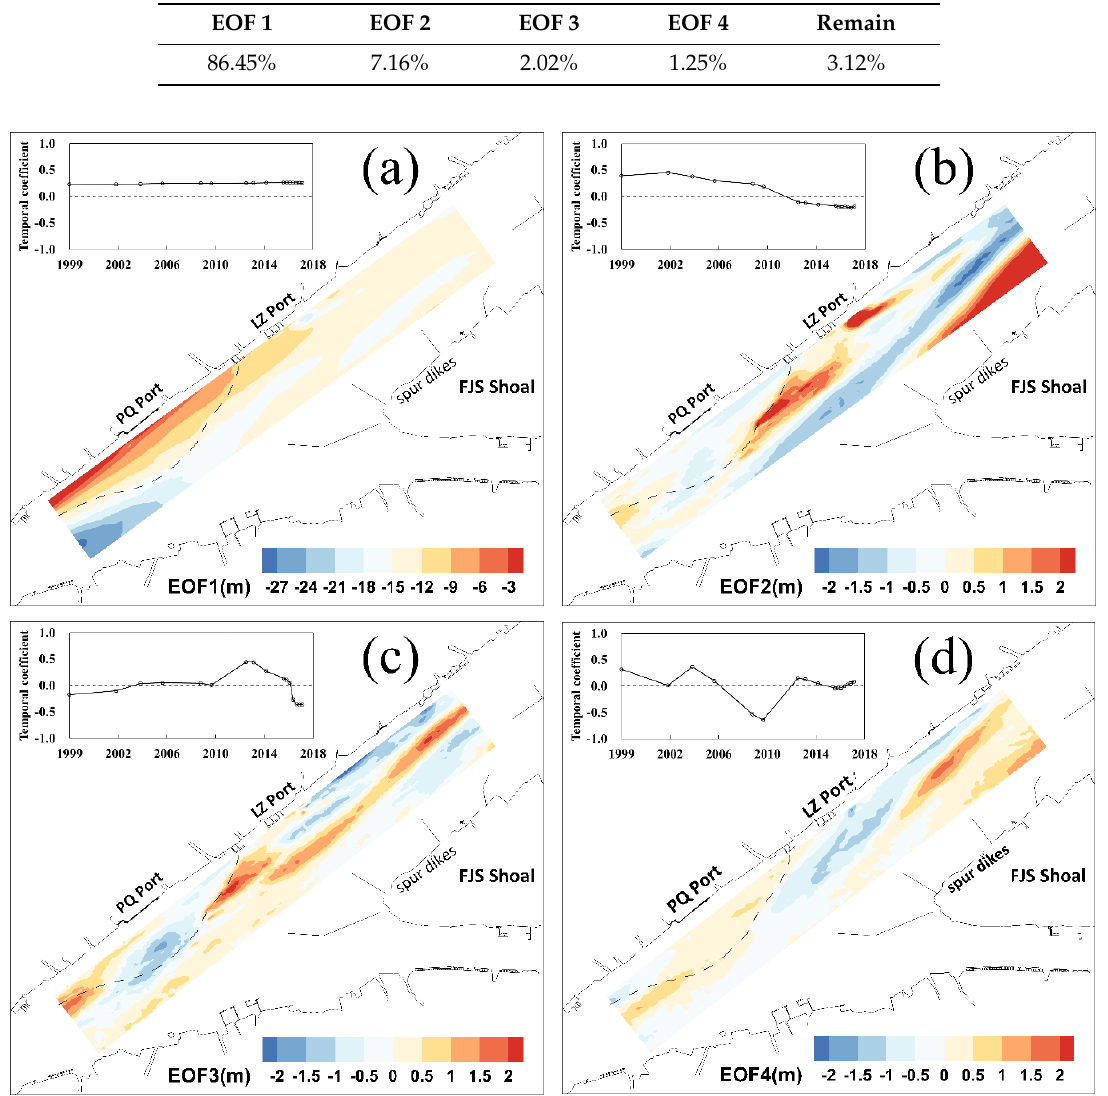
Table 3. Percentage of the total variability represented by the first four eigenfunctions of EOF analysis.